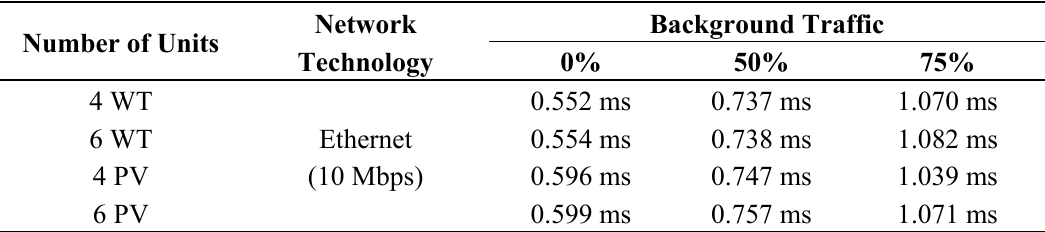
Figure 14. ( a ) Average ETE delay of Ethernet-based architecture for four WTs; ( b ) Average ETE delay of Ethernet-based architecture for four PVs. Table 10. Average ETE delay (ms) of Ethernet-based architecture for the smart-building. (two-level network architecture, server is 50 m